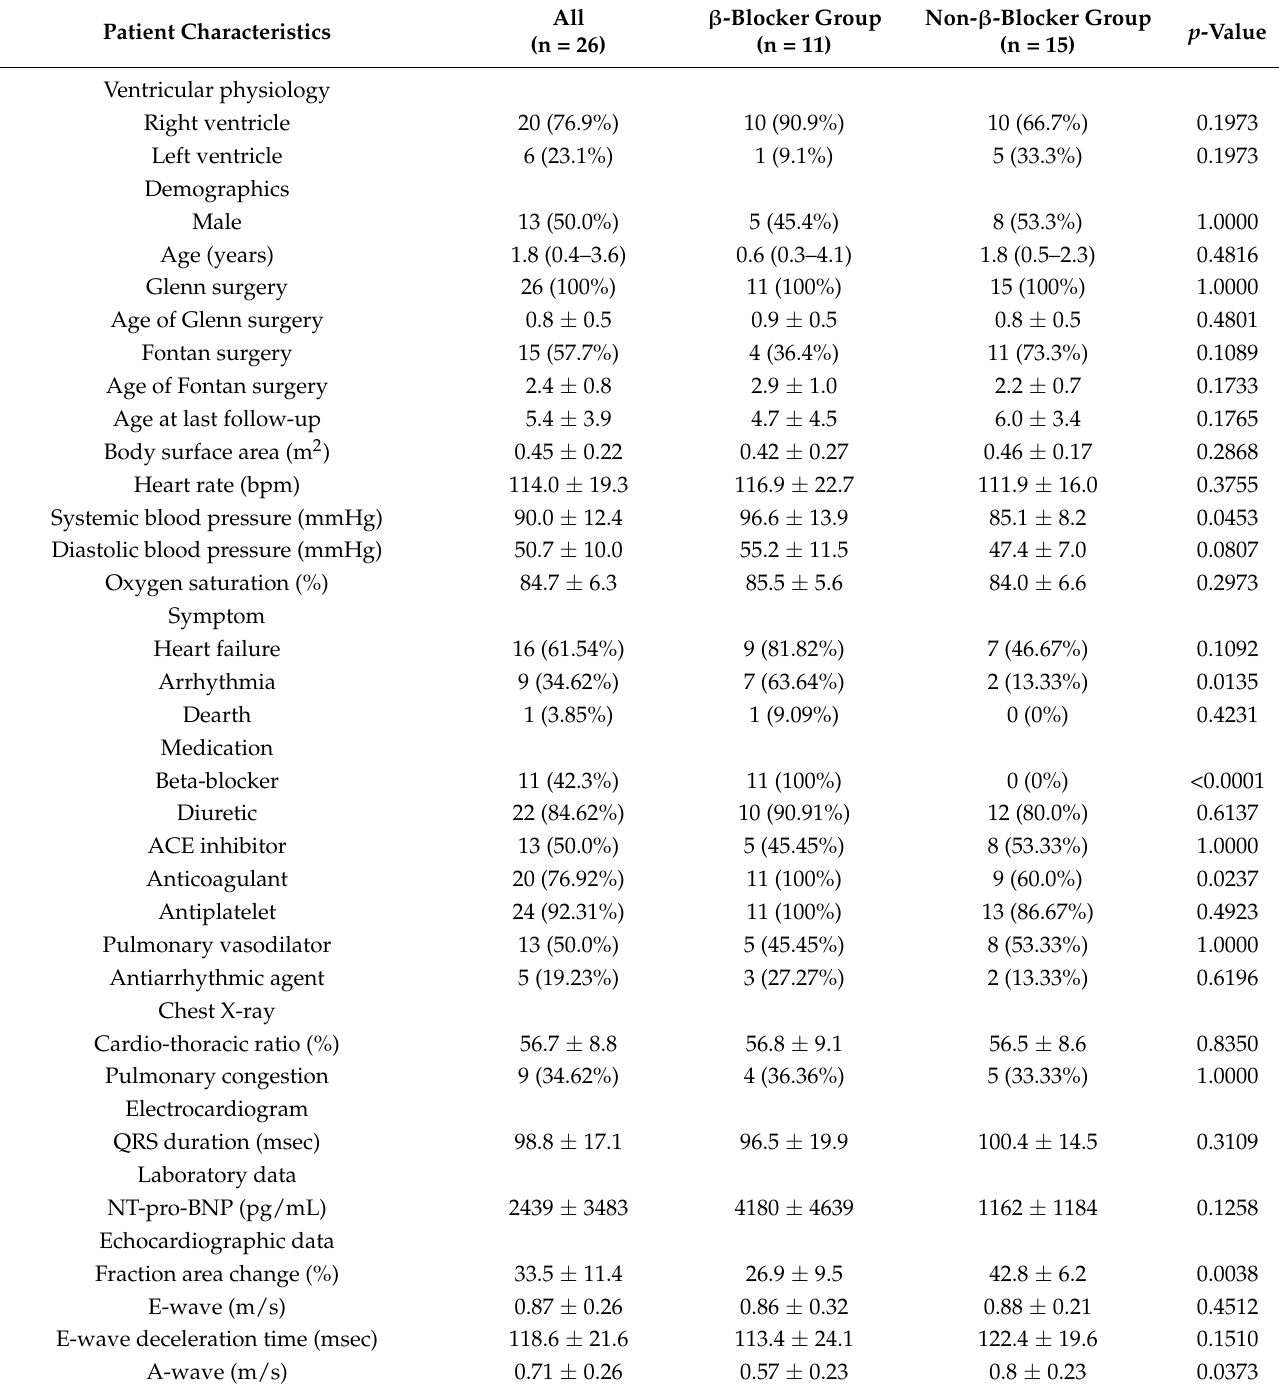
Table 1. Baseline characteristics of the